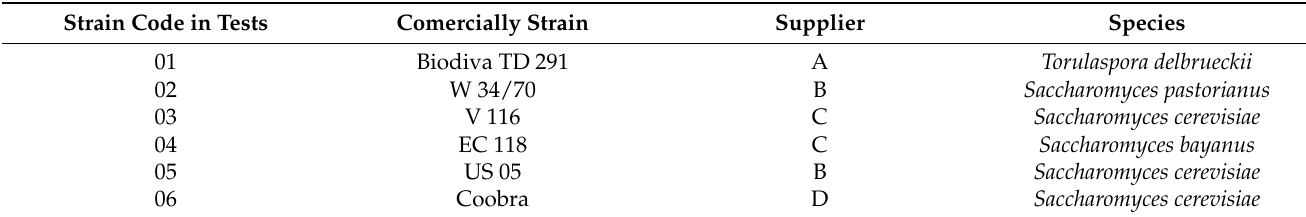
Table 1. List of commercially available yeast strains used in the presented